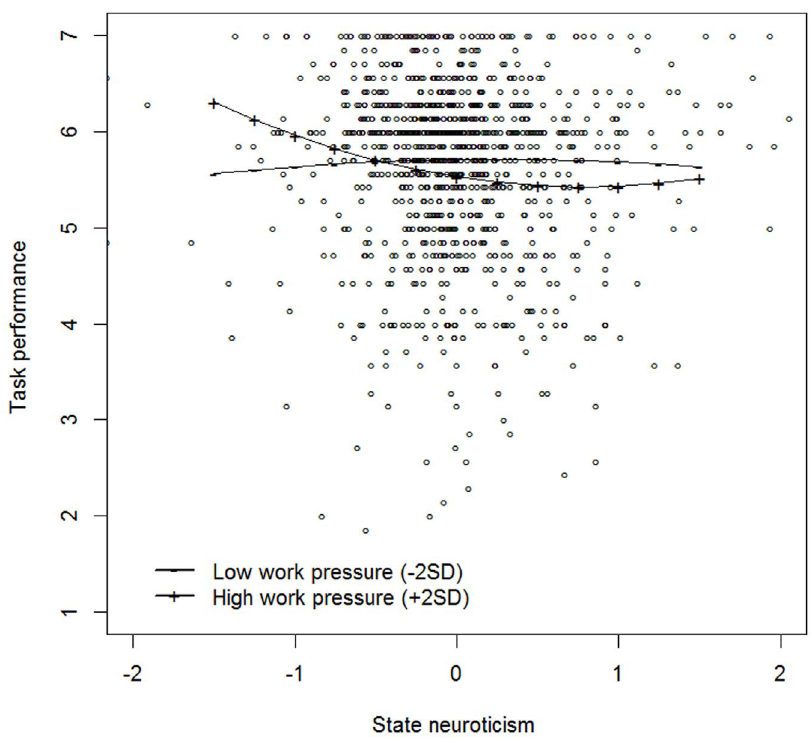
Figure 3. The moderating effect of low ( 2 2 SD ) and high ( + 2 SD ) levels of momentary work pressure on the state neuroticism – task performance relationship (Study 3).